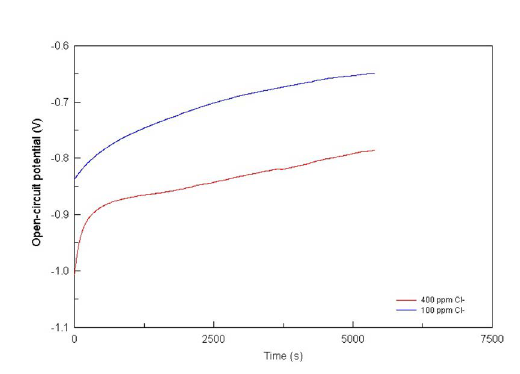
Figure 8. OCP versus time for AA7075-T73 in machining fluid with low and high chloride concentrations The final potentials after 1.5 h immersion, which are known as corrosion potentials Ecorr, are -0.649 V/SCE and -0.785 V/SCE in low and high chloride concentration